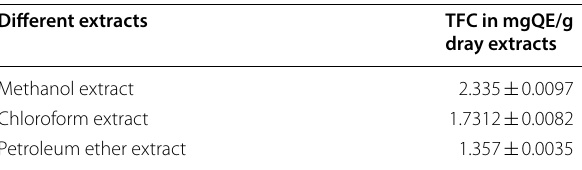
Table 2 Total flavonoid content of the extracts of P.